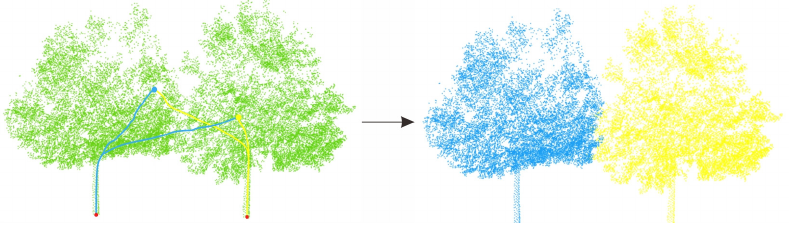
Figure 8. Individual tree optimization. The left figure shows two trees with overlapping crowns before optimization. The shortest path length from the blue point to the bottom of the left tree is obviously smaller than the shortest path length from it to the bottom of the right tree, so the blue point is classified as the same class with the bottom of the left tree. The right figure is the result of optimization.